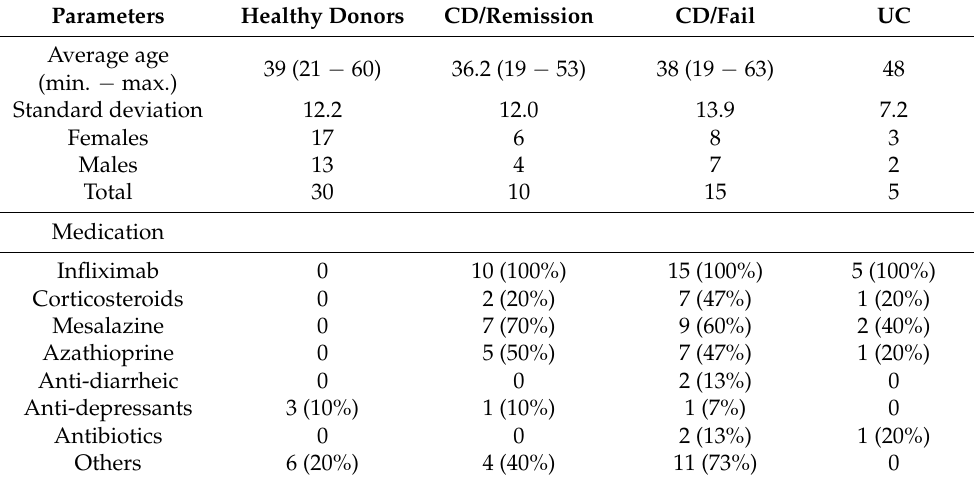
Table 1. Descriptive Data of Healthy Donors and IBD Patients. CD, Crohn’s disease; UC, ulcerative colitis. Failure or remission as indicated for CD patients refers to infliximab therapy. Medication listed as “others” refers to other drugs of minor relevance for IBD, such as antihypertensives and anti-diabetics.